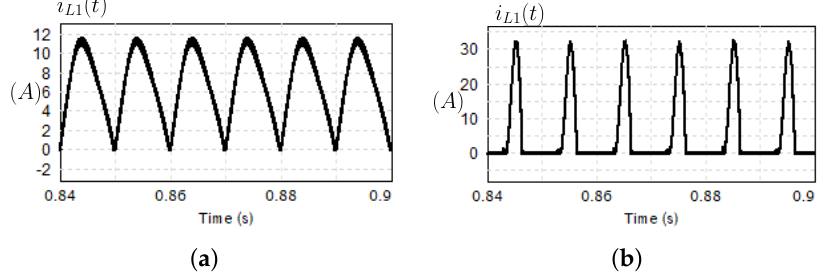
Figure 9. Inductor current i L 1 ( t ) in buck mode: ( a ) Without minimum phase condition. ( b ) With minimum phase